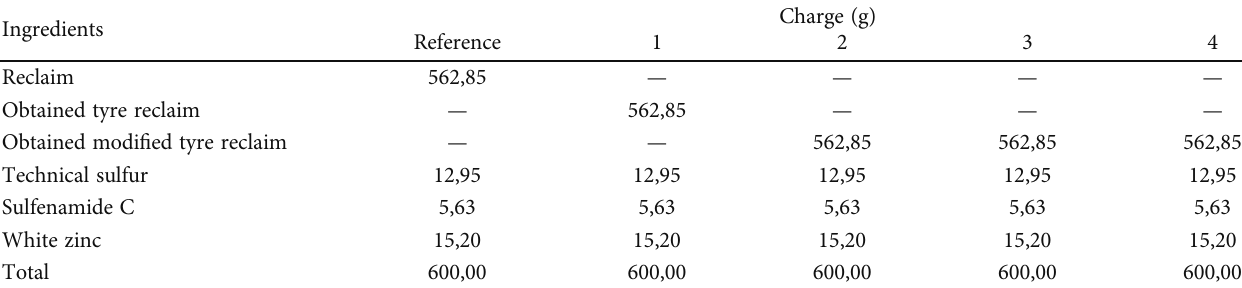
Table 3: The formulation for manufacture of sleeper pad OP 356 and CP 328 (for a charge of 0.6kg).